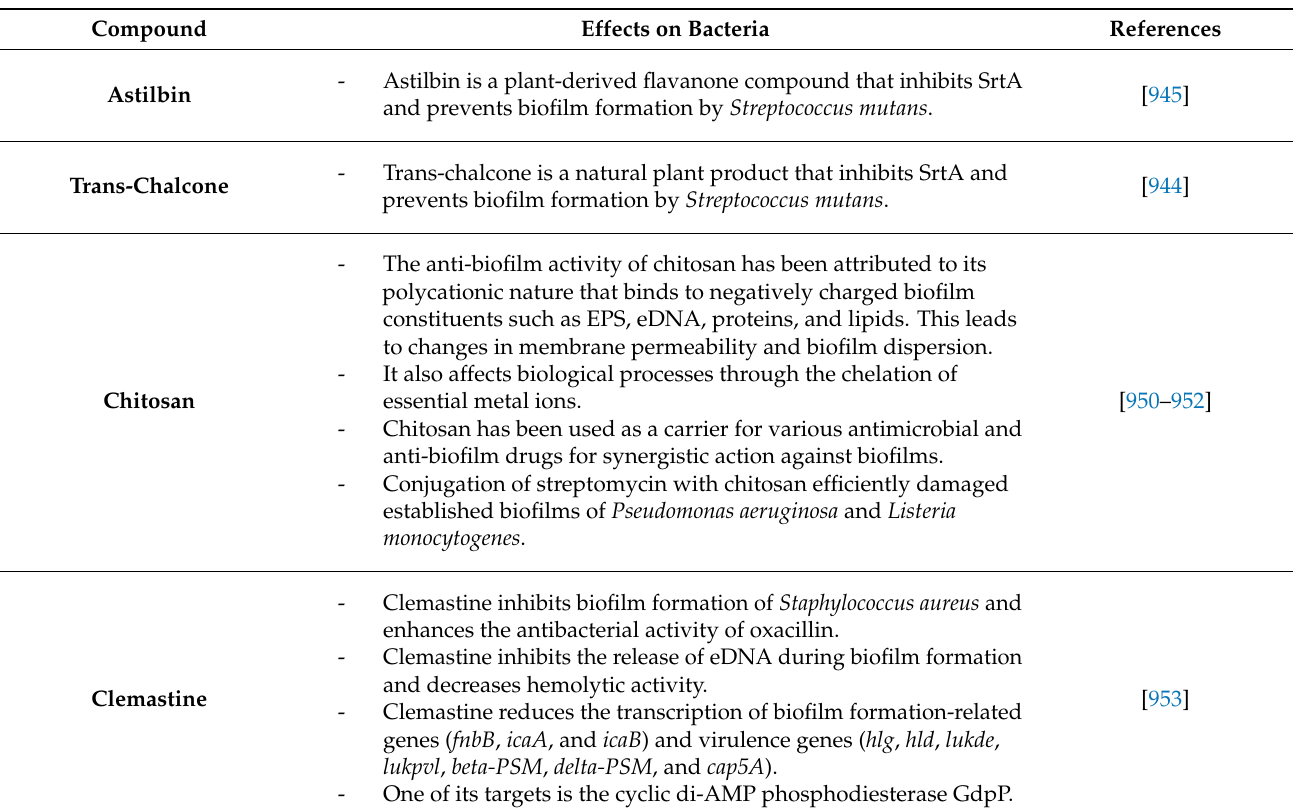
Table 5. Examples of biofilm inhibitors. Effects on